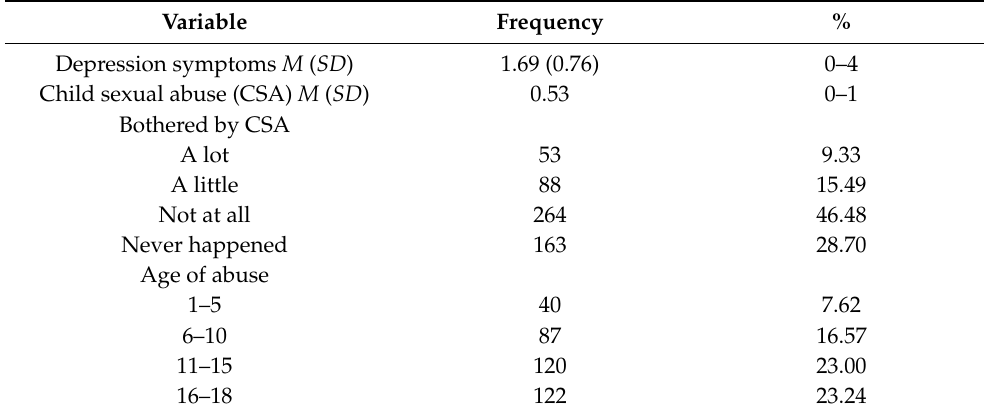
Table 2. Frequencies and percent of CSA variables and the outcome of depression